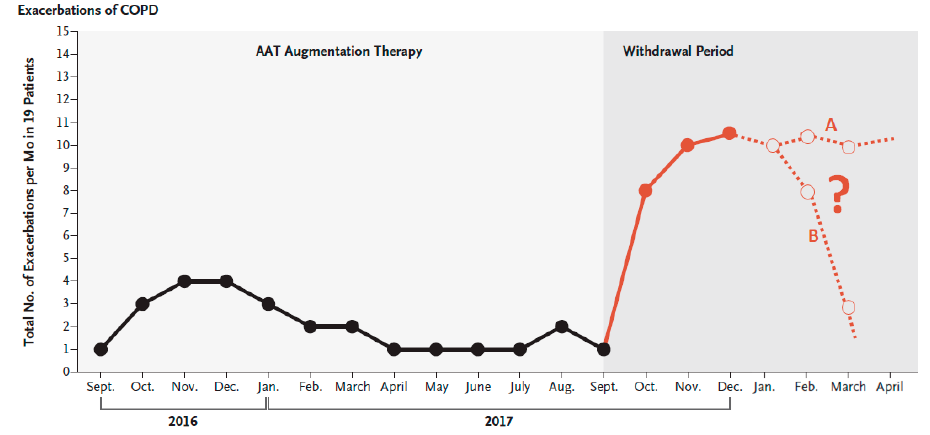
Figure 6. Total number of pulmonary exacerbations per month in the 19 patients in Ireland receiving AAT augmentation therapy for AAT deficiency–associated emphysema during the year before the study (black line) and during the withdrawal period (red line), as reported in the original article. Reproduced with permission from Reference [54]. On the right, we have added (dashed line) two possible hypothetical changes that the curve could have had if the patients had been followed longer, with two possibilities: curve A, with a persistent increase of exacerbations risk, and curve B, with a transient increase in the exacerbation risk. COPD, chronic obstructive pulmonary disease.